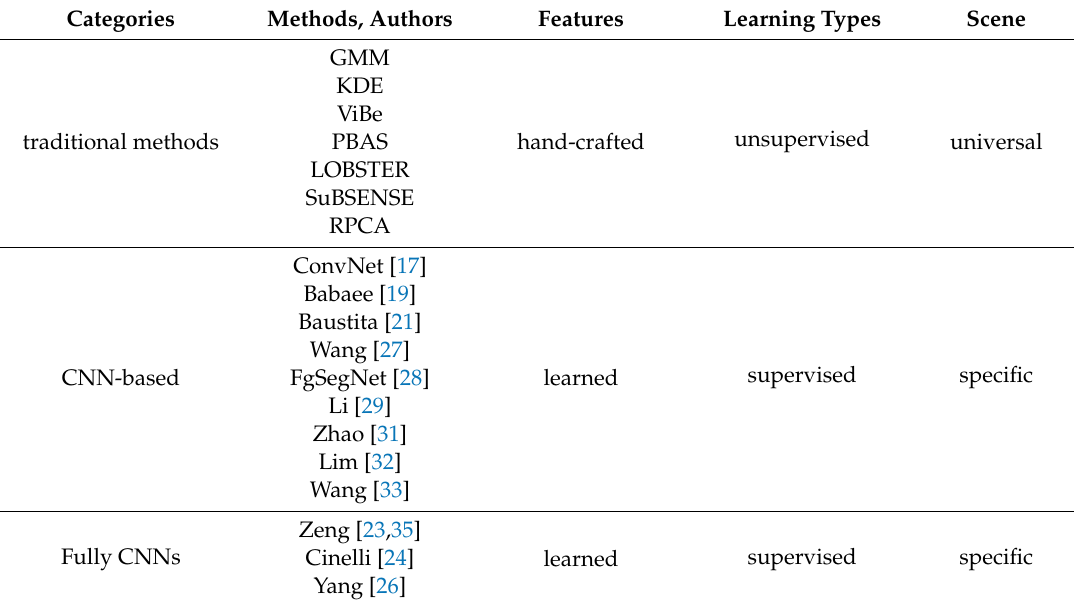
Table 1. An overview of background subtraction